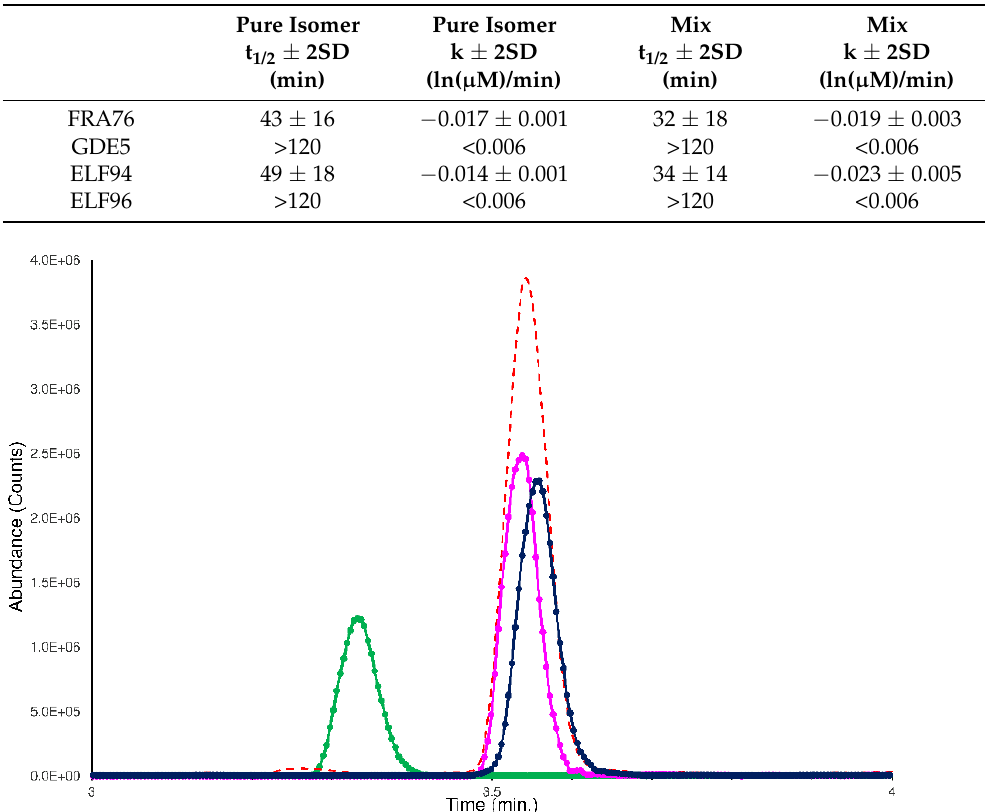
Table 2. The characteristic degradation parameters, half time (t 1/2 ), degradation rate (k), with the estimated standard deviations (SD), calculated by conventional quantitative or LEDA processing of the data from the series of spiked human plasma samples.